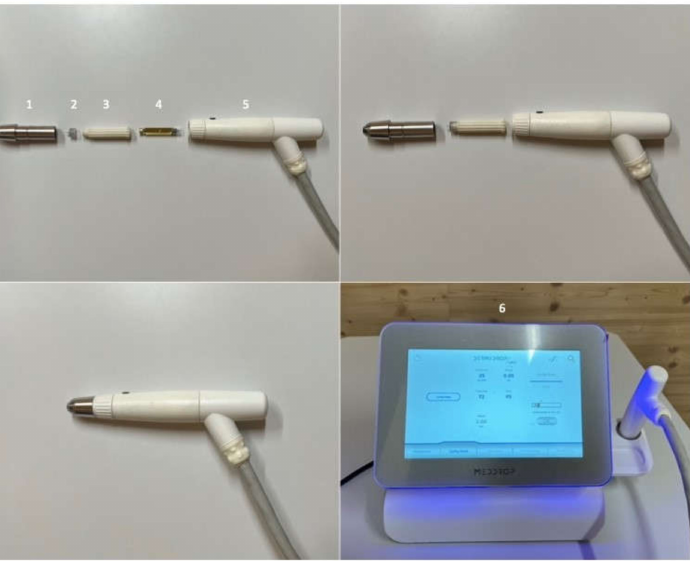
Figure 1. DERMADROP TDA system; (1) applicator tip, (2) TDA pen, (3) cartridge case, (4) cartridge, (5) applicator body, (6) DERMADROP